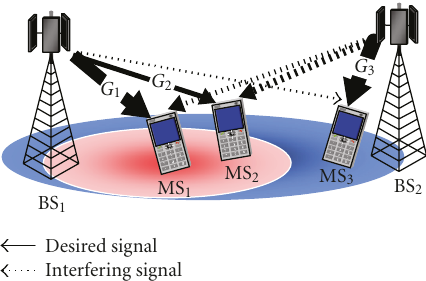
Figure 3: Busy burst with interference tolerance signalling (BB- ITS) in the downlink. The ovals represent the exclusion region formed with